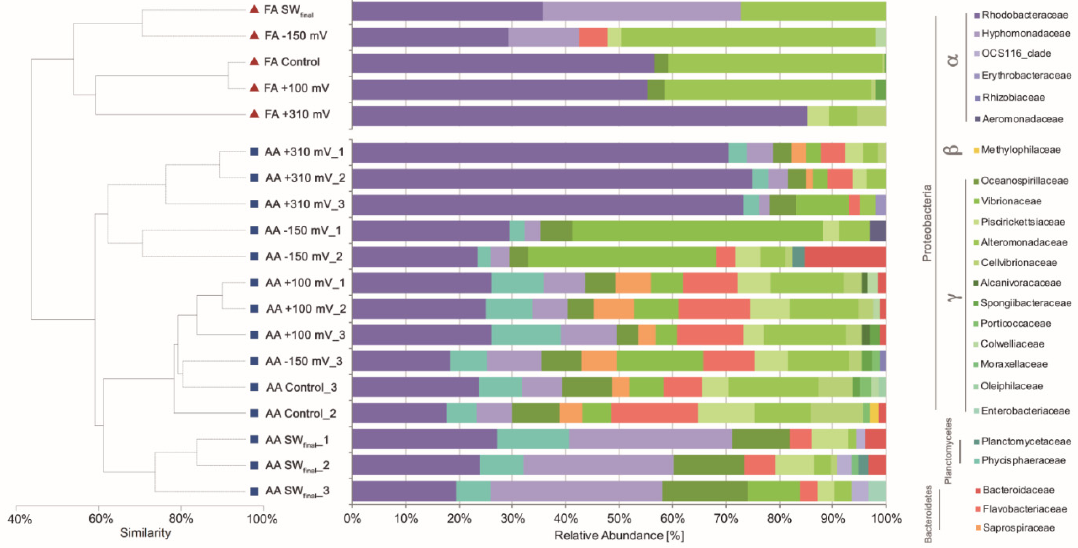
Figure 4. Cluster and relative abundance family-level taxonomic analysis of the bacterial communities associated with each treatment. Table 1. Relative abundance (%) of most-abundant genre identified by amplicon analysis (AA) in each